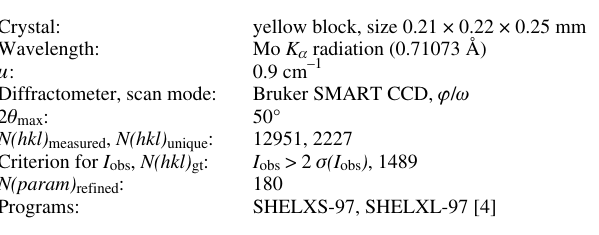
Table 1. Data collection and handling.